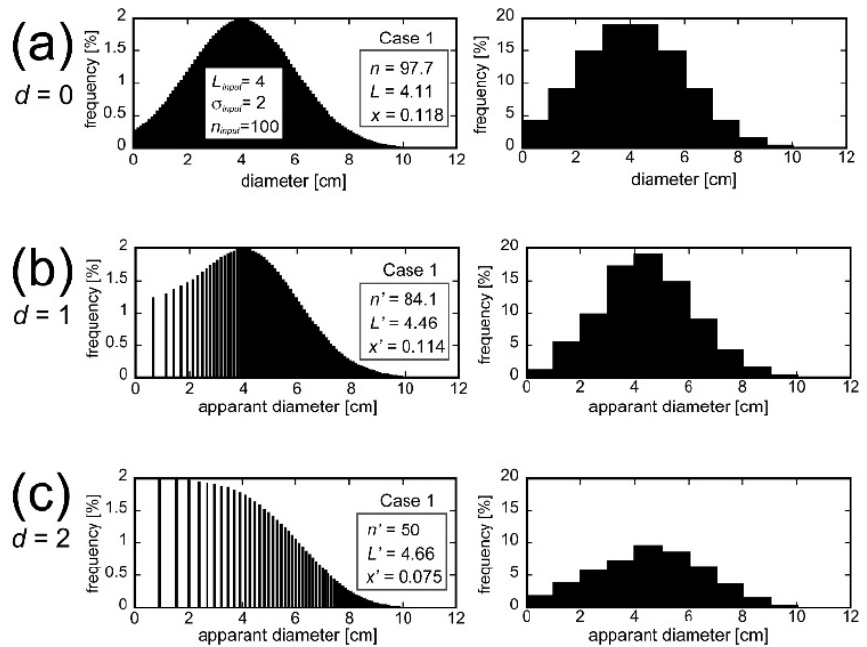
Figure 7. Histograms showing the results of calculations for various d values in Case 1. ( a ) d = 0; ( b ) d = 1; ( c ) d = 2. See text for details.